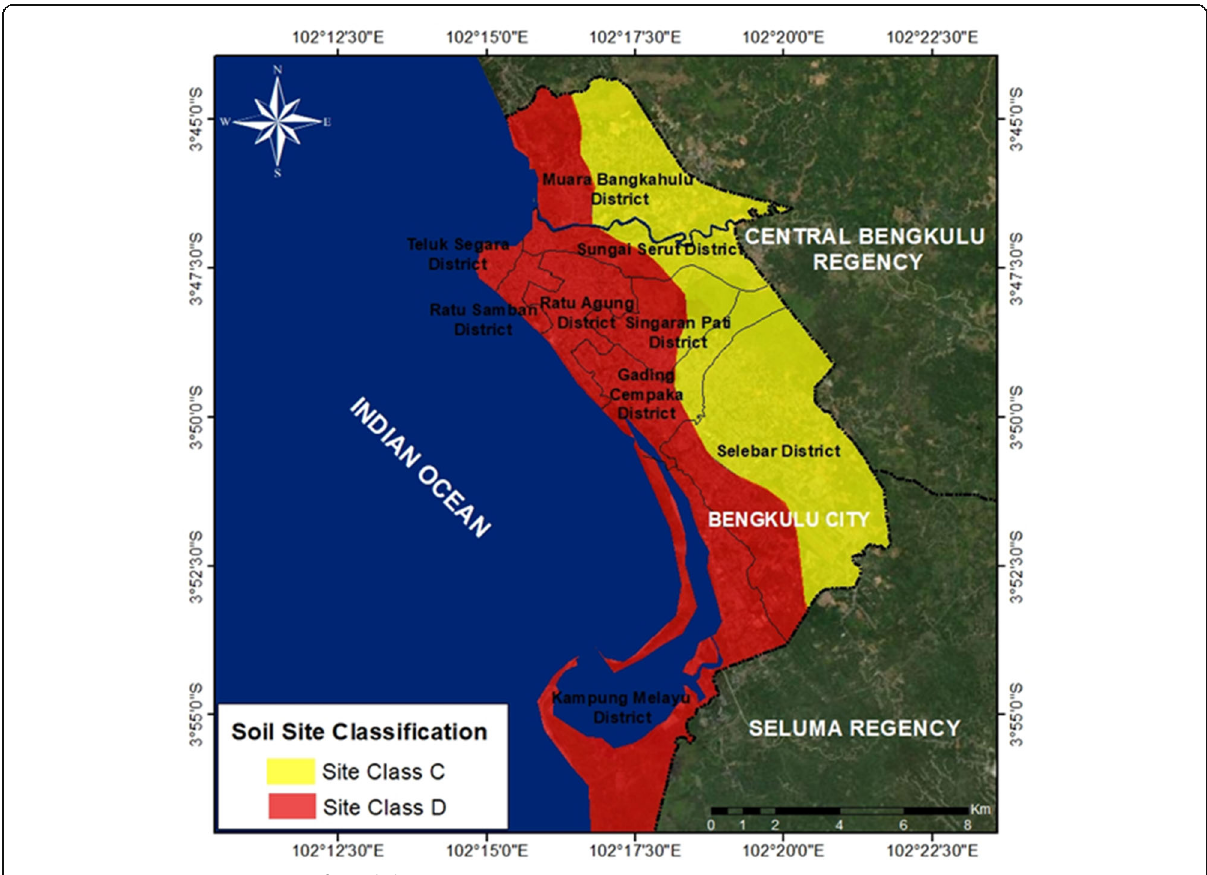
Fig. 11 Seismic microzonation map of Bengkulu